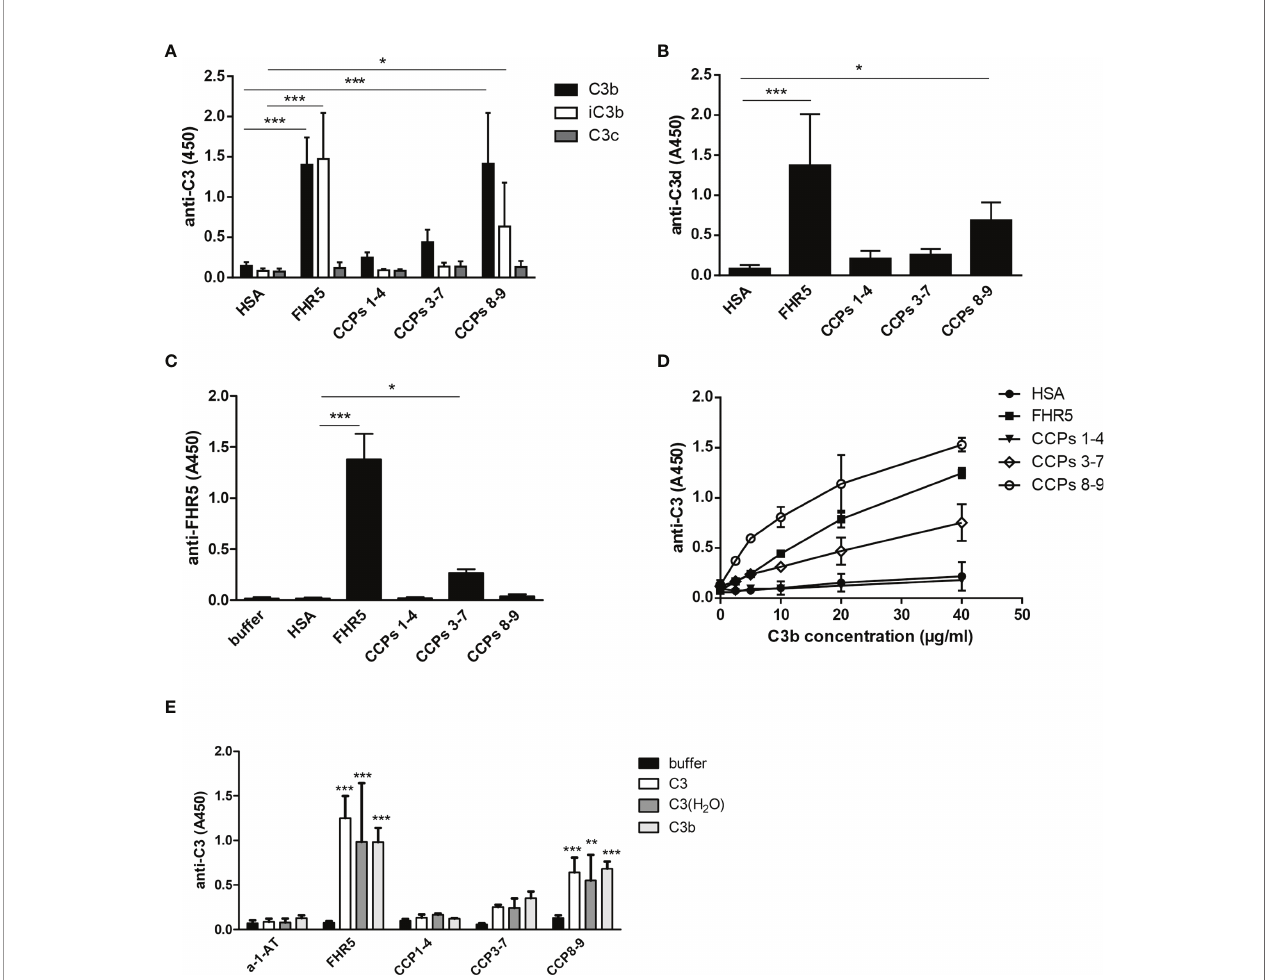
FIGURE 5 | Binding of FHR5 and its fragments to C3b, iC3b, C3c and C3d. (A) FHR5, CCPs 1-4, CCPs 3-7, CCPs 8-9 and HSA were immobilized at 5 µg/ml in microplate wells. After blocking, 20 µg/ml C3b, iC3b and C3c were added. Bound proteins were detected using HRP-conjugated anti-human C3 Ab. (B) C3d binding to FHR5 also was measured by ELISA. FHR5 and its fragments were coated and incubated with 10 µg/ml C3d. Binding of C3d was measured with an anti-human C3d Ab and the corresponding secondary Ab. (C) In reverse setting, C3b was coated (20 µg/ml) and, after blocking, microplate wells were incubated with 20 µg/ml FHR5, CCPs 1-4, CCPs 3-7 and CCPs 8-9. HSA was used as a control protein. Binding of FHR5 and its fragments was detected by a polyclonal goat anti-FHR5 and HRP- conjugated secondary Ab. (D) Dose-dependent binding of C3b to FHR5 and its fragments was measured as shown in (A) ; C3b was added in increasing concentrations. Data are means ± SD derived from fi ve (A – C) or two (D) independent experiments. *p < 0.05, ***p < 0.001, one-way ANOVA. (E) Binding of C3, C3(H 2 O) and C3b to immobilized FHR5 and its fragments was measured by ELISA using HRP-conjugated polyclonal anti-C3 antibody. Data are means + SD derived from four experiments. **p < 0.01, ***p < 0.001, one-way ANOVA, compared to the negative control protein alpha-1-antitrypsin